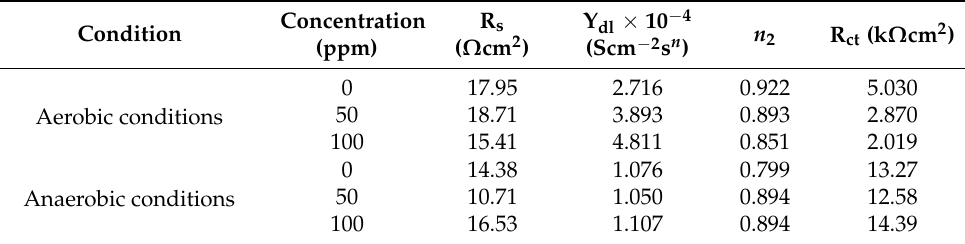
Figure 5. Equivalent circuit model for fitting Nyquist diagrams. Table 2. Fitting results of electrochemical impedance spectroscopy under aerobic and anaerobic conditions.